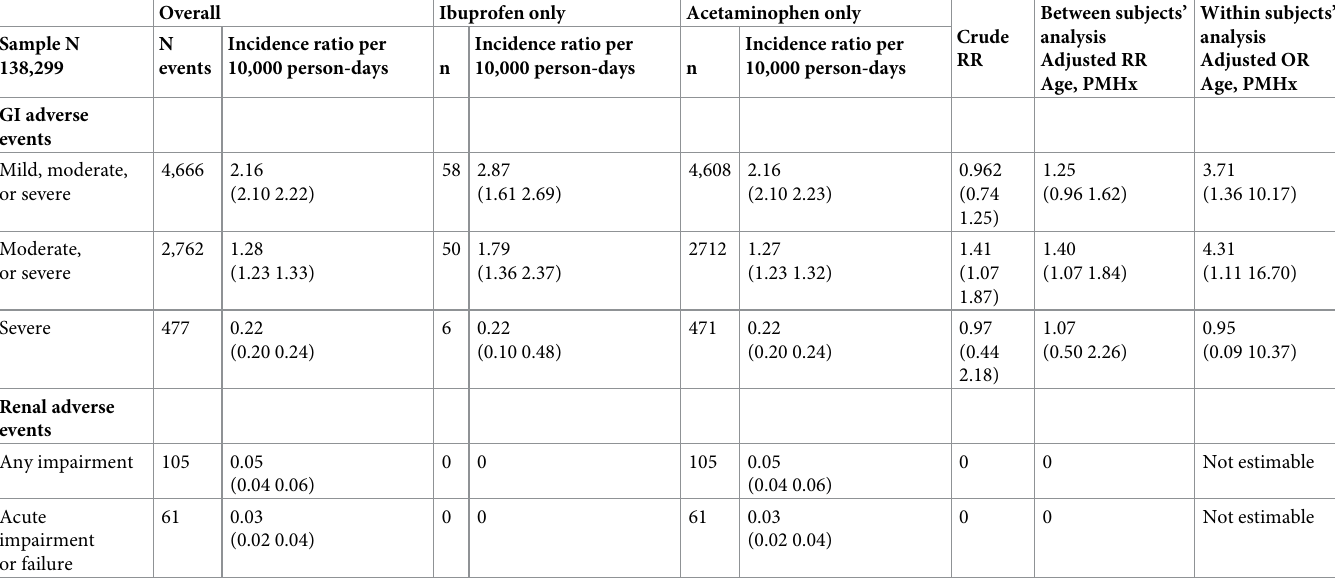
Table 8. Hypothesis 2 at six-month follow